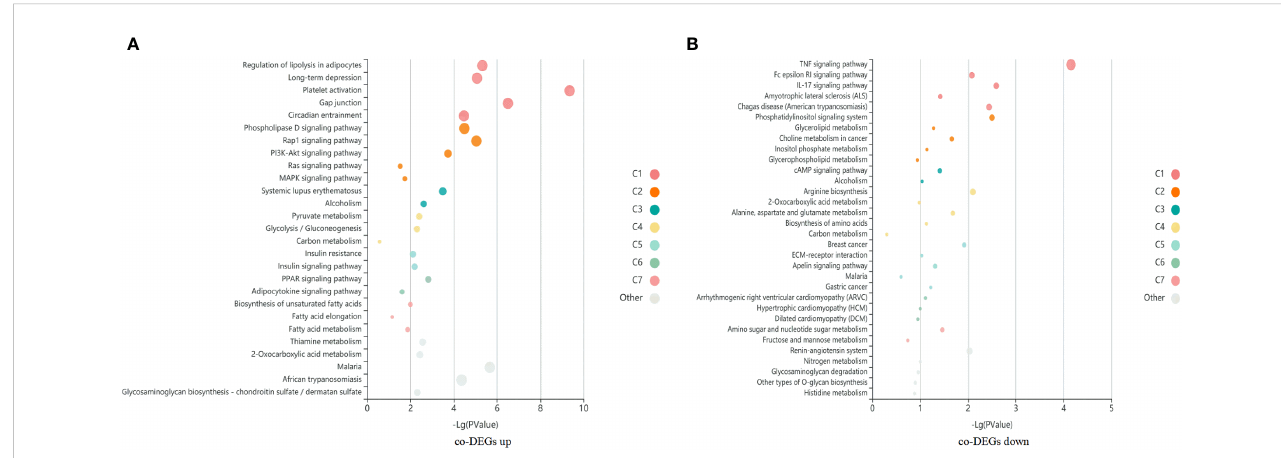
FIGURE 5 A KEGG pathway enrichment analysis was conducted to explore the most signi fi cantly enriched pathways for co-DEGs. Each bubble represents an enriched function, and the size of the bubble from small to large: [0.05,1], [0.01,0.05), [0.001,0.01), [0.0001,0.001), [1e-10,0.0001), [0,1e-10). The color of the bar is the same as the color in the circular network, which represents different clusters. For each cluster, if there are more than 5 terms, top 5 with the highest enrich ratio will be displayed. (A) KEGG enrichment bubble map of co-upregulated differential genes in case compared with M and ALL groups. (B) KEGG enrichment bubble map of co-downregulated differential genes in case compared with M and ALL